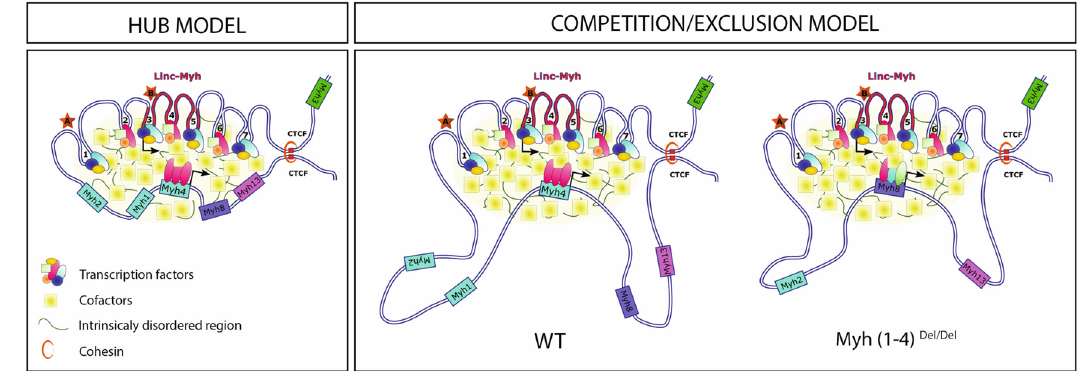
Fig. 7 Two models explaining the complex regulation of f Myh genes by the shared SE. The SE is composed of seven enhancer elements (1 – 7) recruiting TF and cofactors allowing the nuclear formation of a phase separation condensate in myonuclei and allowing robust f Myh expression, adapted from Sabari et al. 16 . Left, in the hub model even the inactive promoters at the locus are associated in the phase-separated droplet in Myh4 + myonuclei. Right, in the competition/exclusion model, Myh2 , Myh1 , Myh8, and Myh13 are excluded from the phase-separated droplet in Myh4 + myonuclei because they are not bound by suf fi cient amount of TF and cofactors. In those myonuclei robust bi-allelic expression of Myh4 is achieved, while transcription of the other genes is not detected 10 . In this competition/exclusion model, the deletion of Myh1 and Myh4 could lead to the maintenance of Myh8 expression through development in speci fi c muscles, (while in others Myh13 is activated (not represented)) due to the absence of competition by Myh4 or Myh1 promoters. Linc-Myh spans enhancers 3 – 5. The models are not to